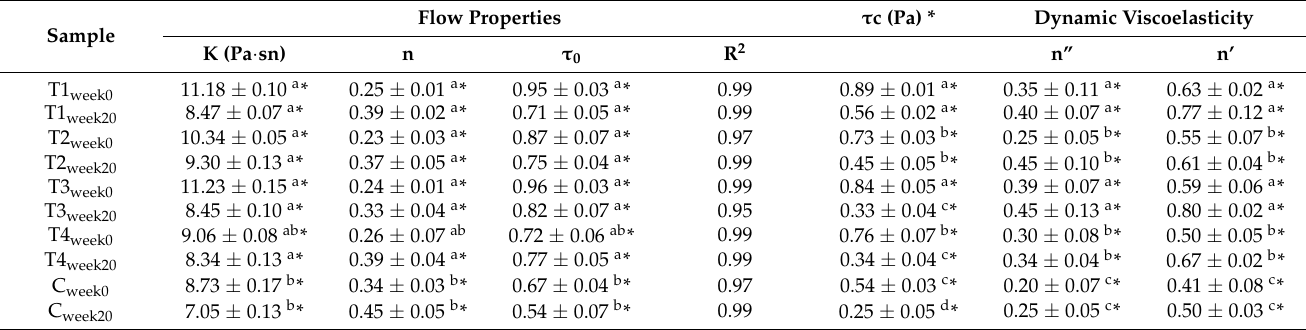
Table 2. Rheological parameters determined from amplitude sweep and steady shear flow experi- ments on Herschel–Bulkley and Power Law models for flow curves and dynamic viscoelasticity of hot sauces formulated with vinegar (control), tequila, bourbon, vodka, and